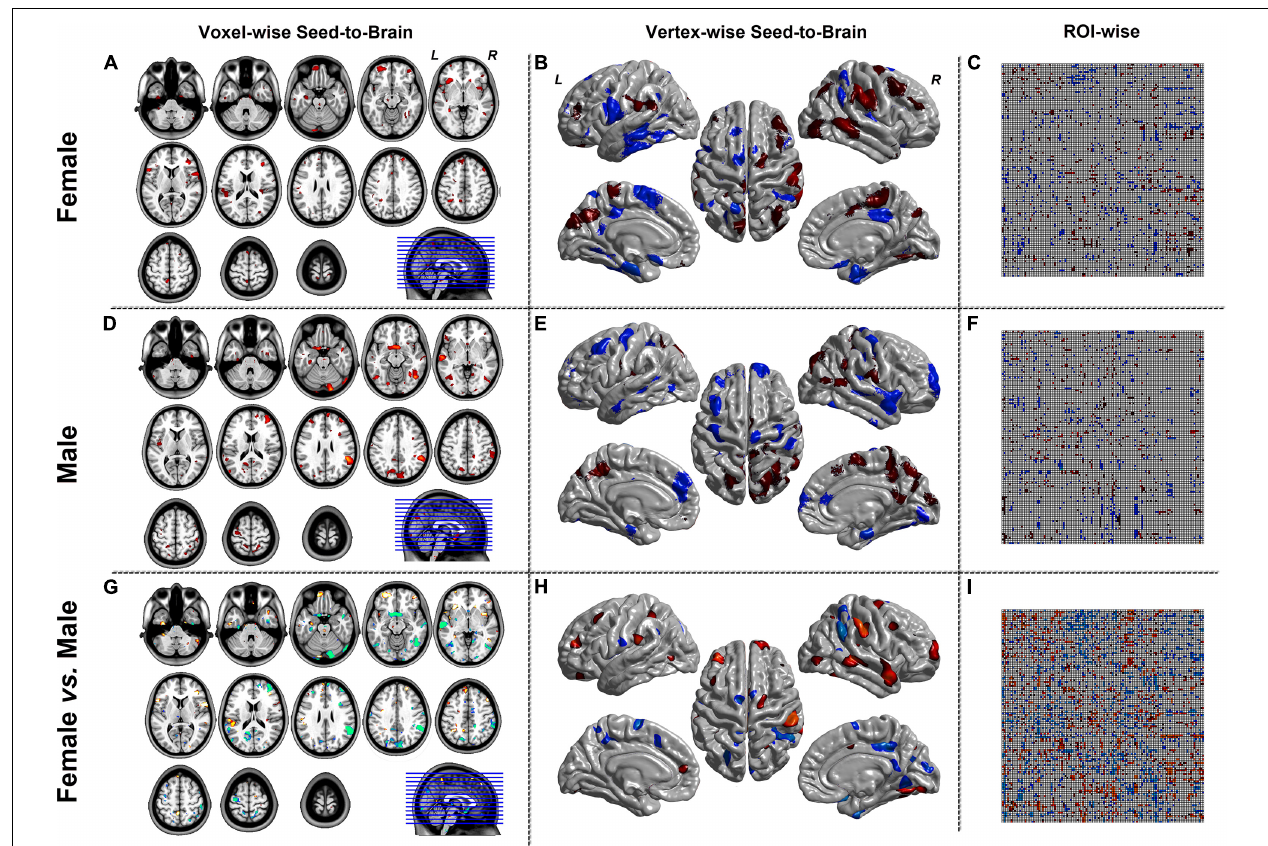
FIGURE 4 | The results of CaSCN mode with X (seed)-to-Y (Brain/Target ROI). Panels (A,D,G) were the results of seed-to-brain connectivity of the GMV. Panels (B , E , H) were the results of seed-to-brain connectivity of thickness. Panels (C , F , I) were the results of ROI-wise connectivity of the GMV with the AAL template. All results were set at the threshold of p < 0.05